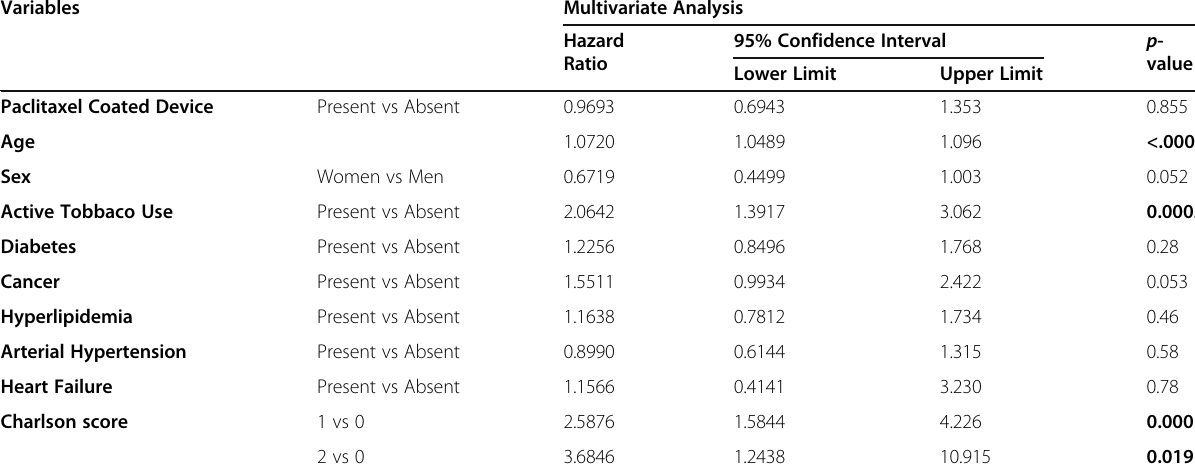
Table 4 Multivariable Cox Regression Analysis for defining the independent factors of all cause death of the entire cohort of patients presenting with claudication and de novo femoropopliteal lesion(s) Variables Multivariate Analysis